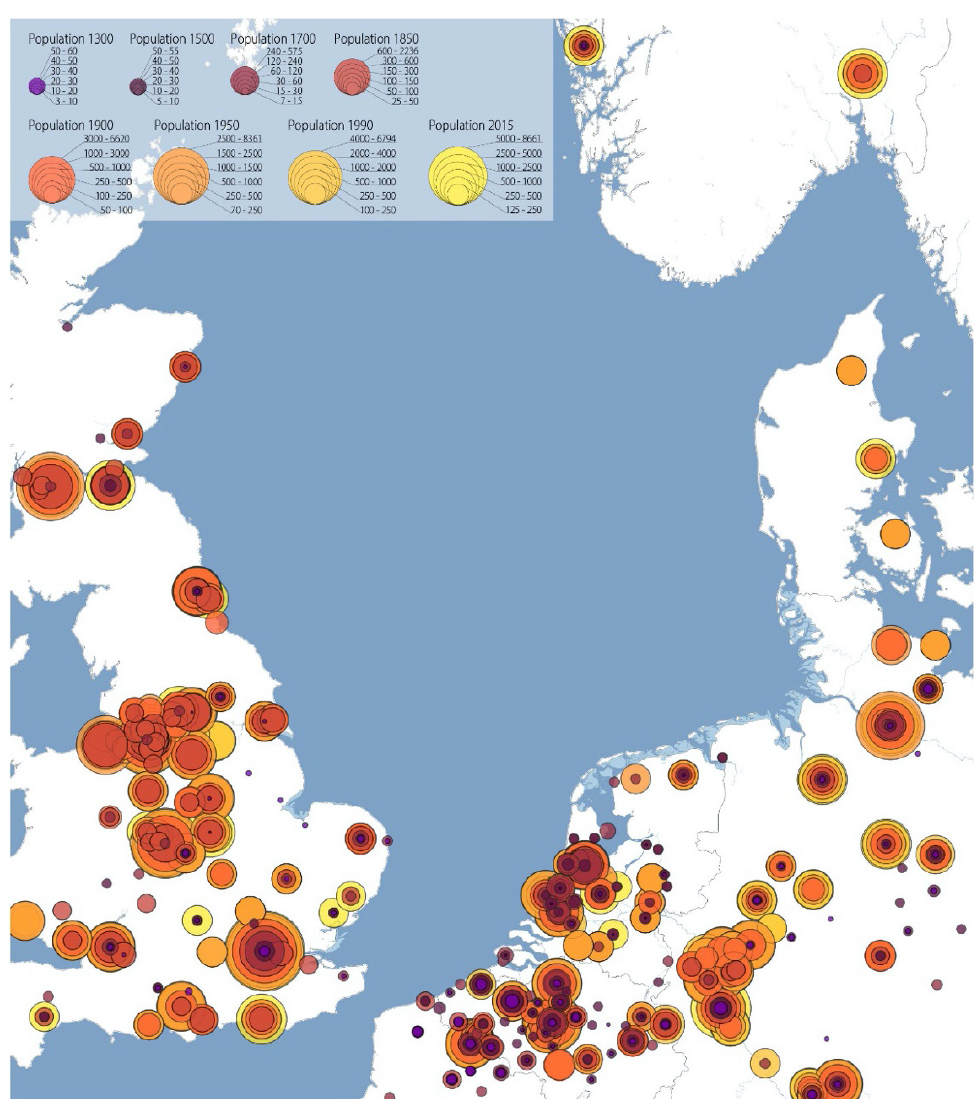
Figure 1. The result of mapping and ranking population numbers in eight survey years. Map by Yvonne van Mil.